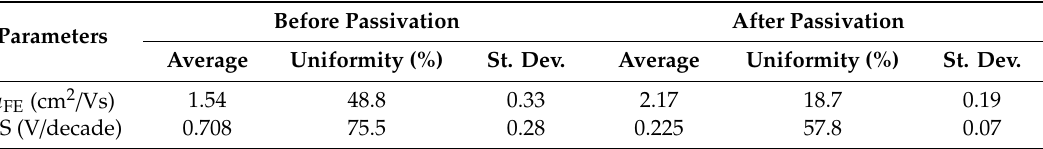
Table 1. The average values, uniformities and standard deviations of saturation mobilities ( µ FE ) and subthreshold swings ( a ) before and ( b ) after PSPI-passivation are shown. The uniformity values were calculated by [(maximum − minimum) / (2 · average)] ×